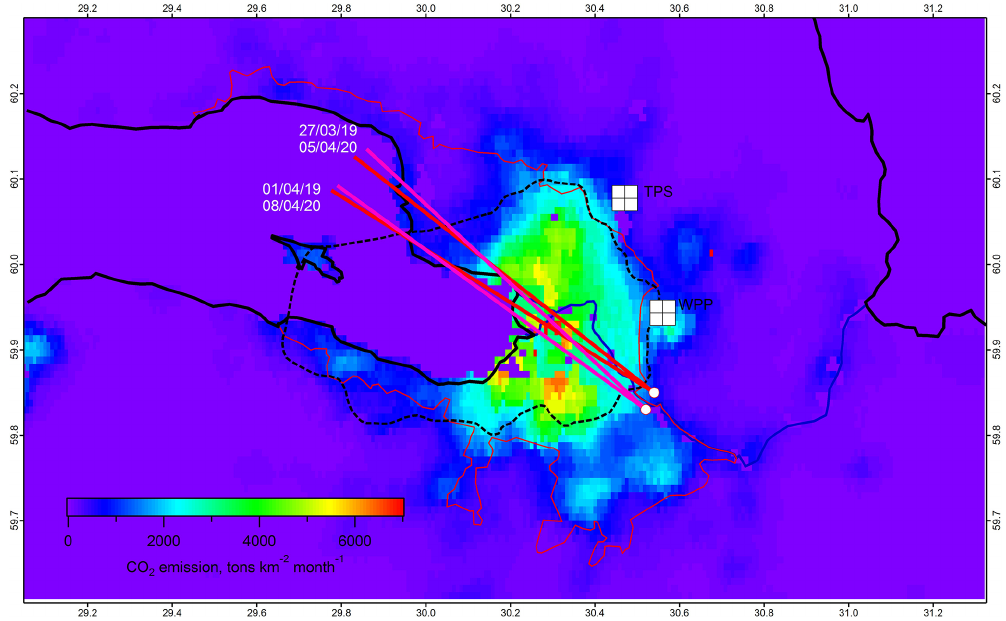
Figure 11. Map of similar air trajectories and similar downwind measurement locations for EMME-2019 and EMME-2020 experiments. For simplicity, the trajectories are marked with straight lines, 50km long, ending at the locations of downwind FTIR measurements. The locations of a thermal power station (TPS) on the northeastern side and a solid waste processing plant (WPP) on the eastern side are also